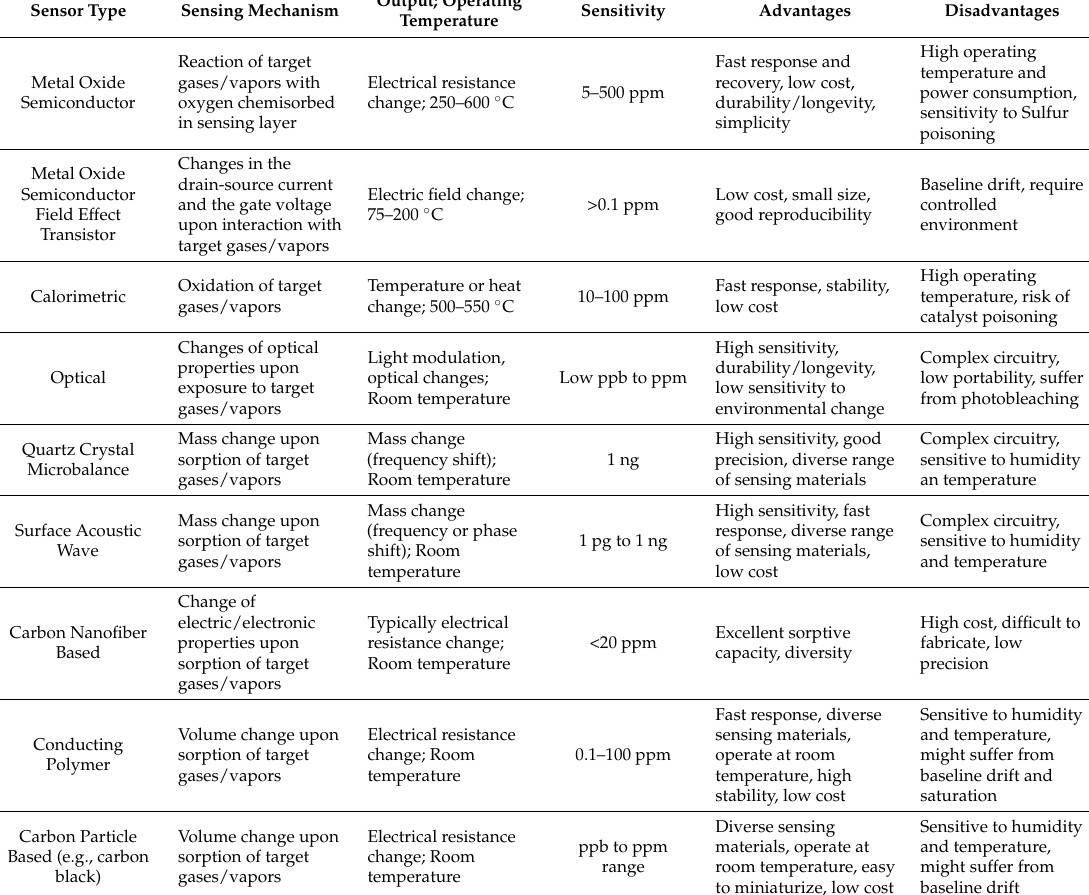
Table 1. Types of gas sensors usually used in electronic nose systems (rough